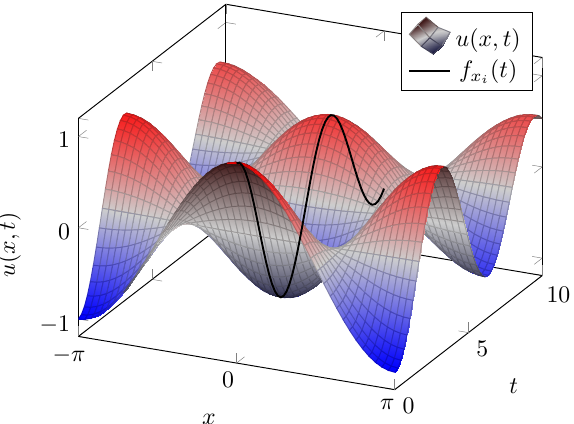
Figure 2. The one-dimensional analytical solution of the damped wave equation. The spatial interval π to π and [ 0,10 ] for the time interval. The feature descriptor f x = 0 is the solid black is chosen from − line and is the function u ( x , t ) restricted to x = 0. For more details on the solution and how we obtain it, we refer the reader to Section